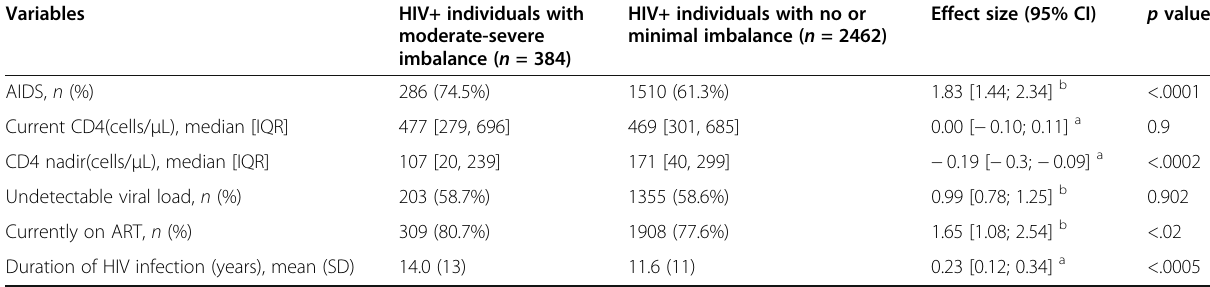
Table 3 HIV disease and treatment characteristics of persons living with HIV according to balance disturbances